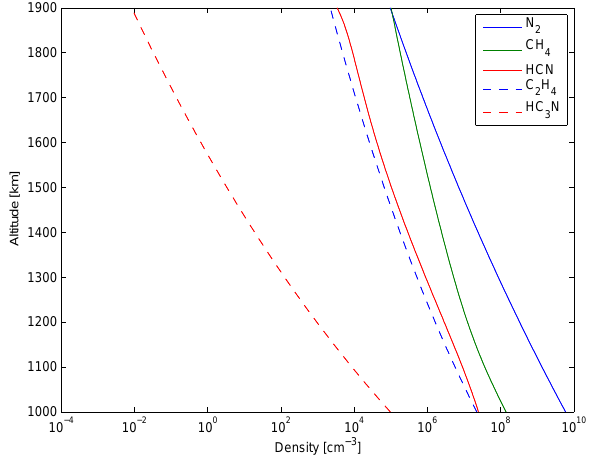
Fig. 7. Ionisation rates for E = 200 eV and F = 1 . 3 × 10 5 cm − 2 s − 1 calculated by the electron transport code (red) and by using the Rees’ formula (blue). Shown in green is the fraction that is due to ionisation of CH 4